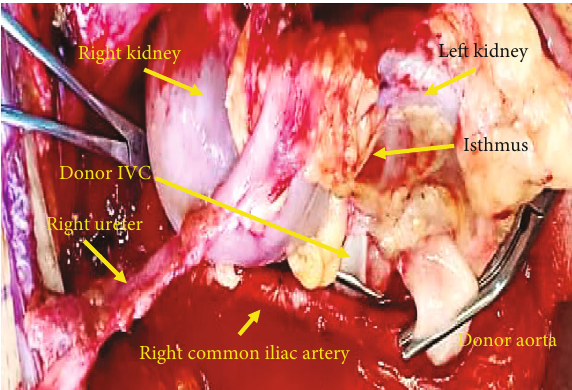
Figure 3: Picture taken before reperfusion of the horseshoe kidney, immediately after completion of anastomosis between inferior end of donor aorta and IVC to the common iliac artery and vein,